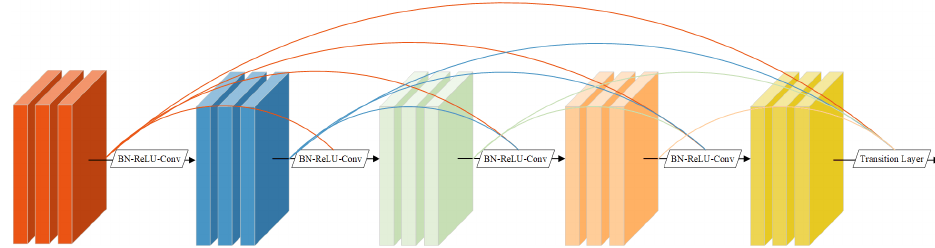
Figure 3. The architecture of the residual network.